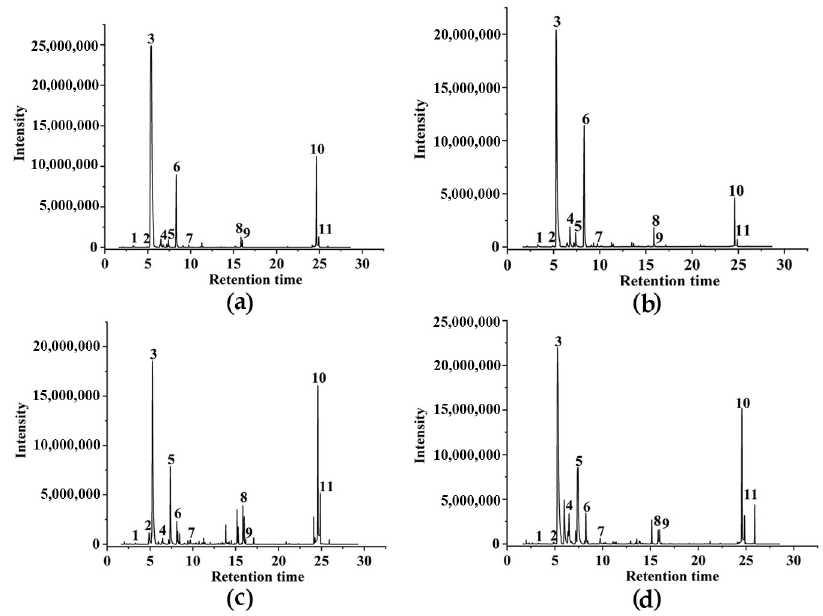
Figure 1. The TIC chromatograms of GC-MS in the four herbs. ( a ) Chuanxiong (